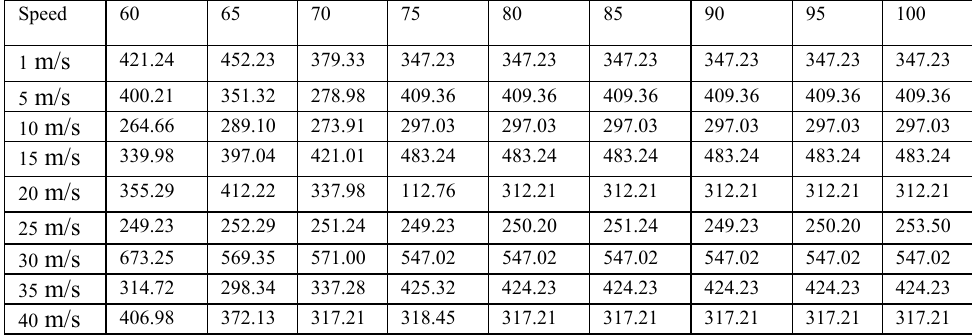
Table 2. Aggregate throughput for